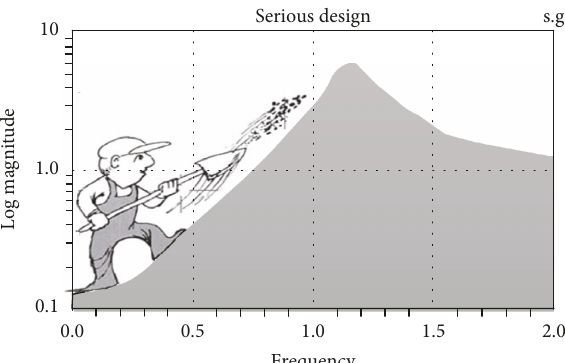
Figure 5: Sensitivity reduction at low frequency unavoidably leads to sensitivity increase at higher frequencies.